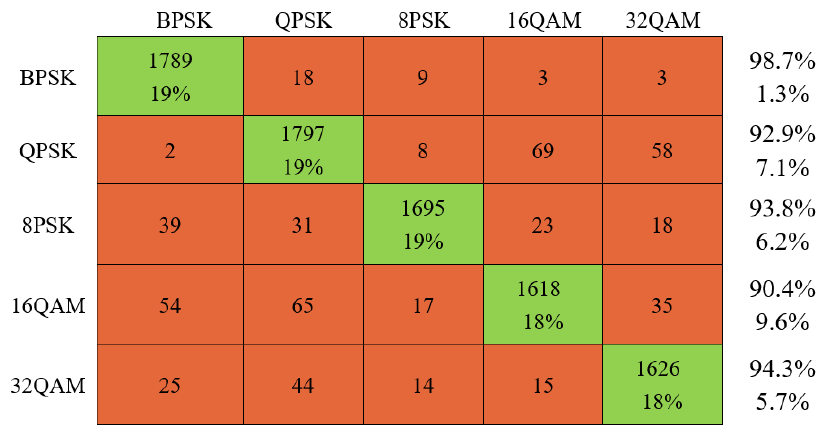
Figure 7. Confusion matrix of KADPC.